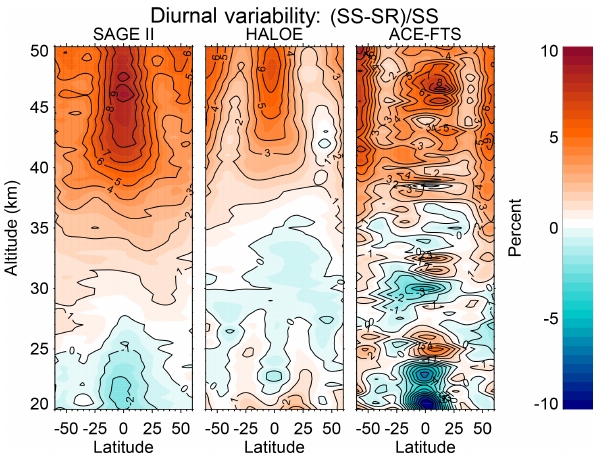
Figure 12. Same as Fig. 3 except the regression is allowed to fit dif- ferent seasonal cycles for each instrument. The lack of orthogonal- ity between the diurnal and seasonal sampling patterns in ACE-FTS makes it impossible to differentiate between the two. SAGE II and HALOE remain unaffected, illustrating sufficient orthogonality and the fact that their seasonal cycles are essentially the